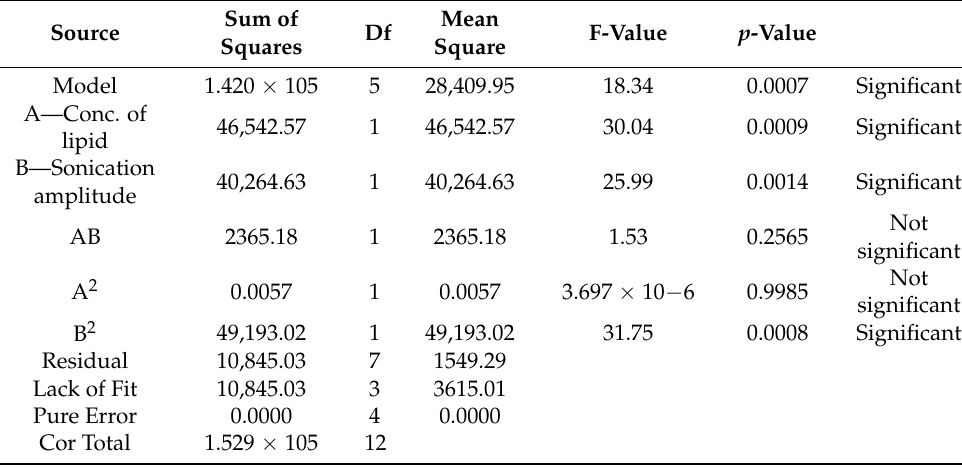
Table 2. ANOVA for the quadratic model of particle sizes of BP-LCNs.